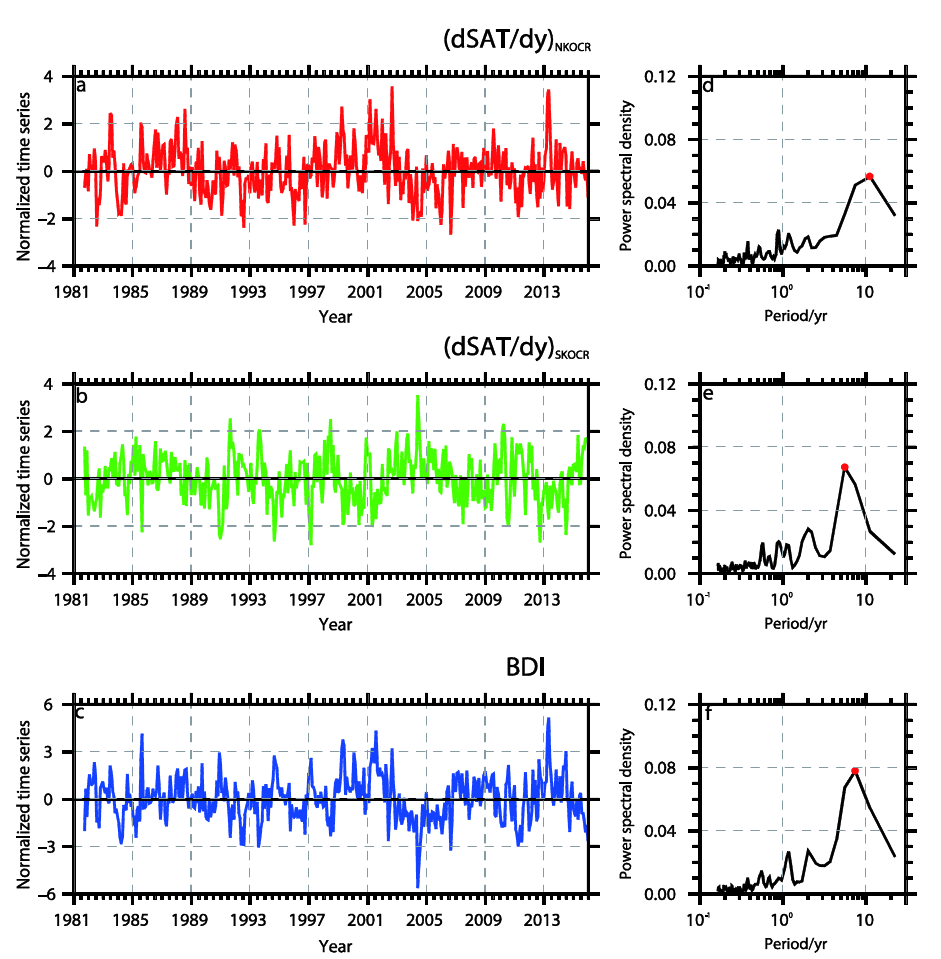
Figure 7. Normalized time series of the ( a ) (dSAT / dy) NKOCR , ( b ) (dSAT / dy) SKOCR , and ( c ) BDI and their corresponding power spectra ( d – f ). Red dots indicate the spectral peak significant at the 95% confidence level.